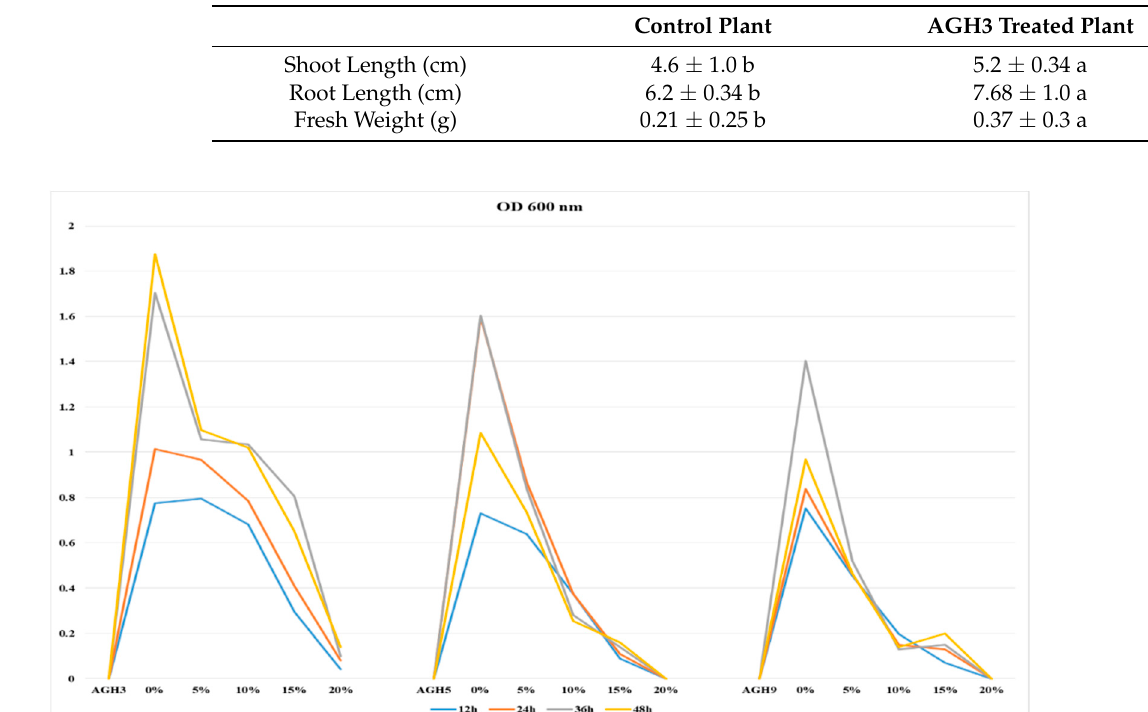
Figure 2. Screening of selected isolates AGH3, AGH5, and AGH9 for PEG tolerance. Table 3. Bioassay assessment for growth promotion activity of the competent isolate AGH3 in Waito- C rice. Different letters in the column show that values are significantly different ( p < 0.05) from each other as evaluated from the DMRT test.